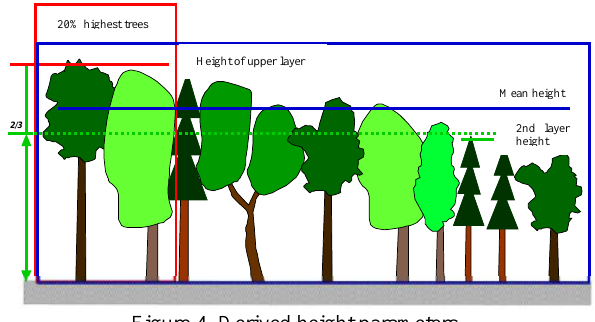
Figure 4. Derived height